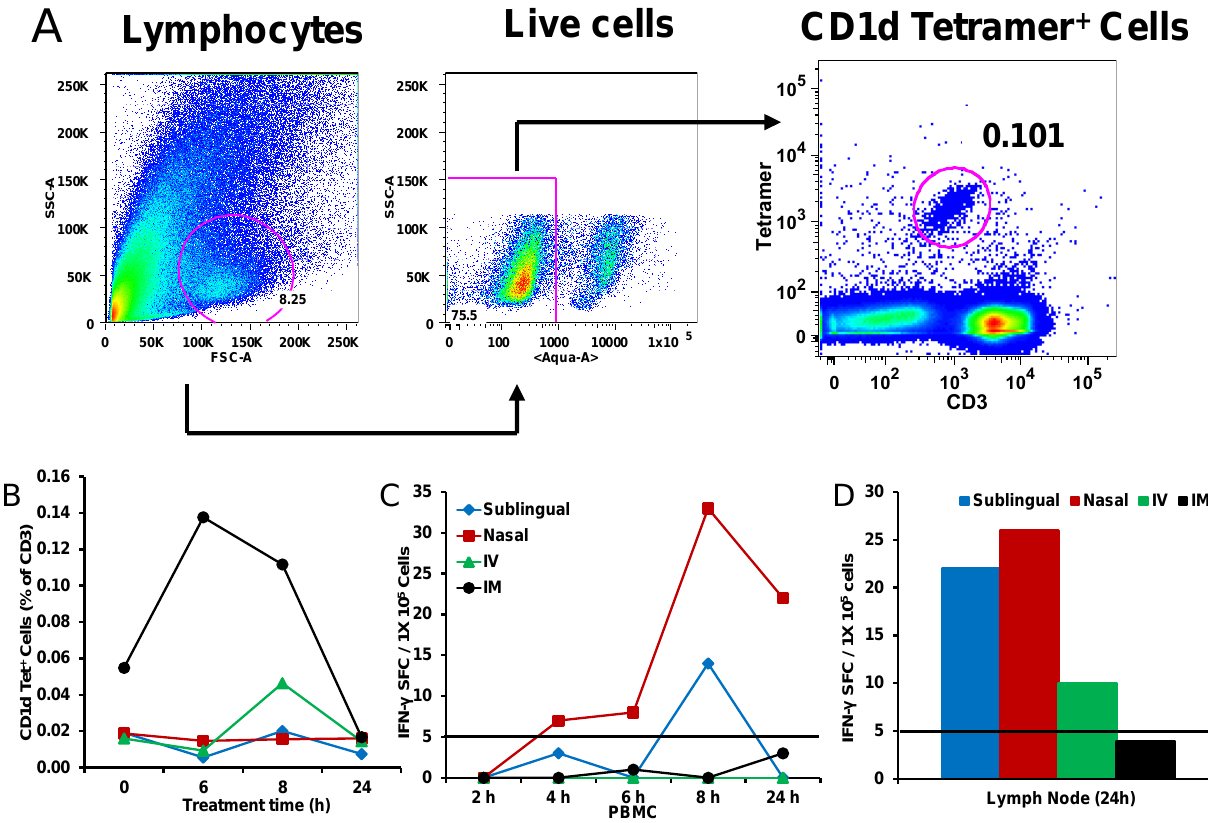
Figure 3. In vivo expansion of natural killer T (NKT) cells with α-GalCer delivered by different routes in rhesus macaques: Individual animals were administered α-GalCer as free drug (125 µg) by sublingual, intranasal (IN), intravenous (IV), and intramuscular (IM) routes followed by determining the percentages of NKT cells in the blood by staining with allophycocyanin (APC)-labeled CD1d tetramer pre-loaded with α-GalCer. The gating scheme ( A ) for the analyses of the NKT cells in the peripheral blood mononuclear cells (PBMC) from a representative animal included first selecting the lymphocytes based on forward scatter (FCS) versus side scatter (SSC), and then live lymphocytes were identified based on staining with Aqua Live/Dead reagent (Invitrogen, Carlsbad, CA, USA). The T cells were then positively identified by CD3 expression followed by the detection of the CD1d tetramer + populations within the CD3 + T cells. Percentages of CD1d tetramer + NKT cells in PBMC isolated from individual monkeys at 0, 6, 8 and 24 h after delivering α-GalCer by the different routes are shown in Figure 3B. Numbers of IFN-γ producing cells within the blood ( C ) and lymph nodes ( D ) after administering α-GalCer by the different routes in individual monkeys as an indication of activated NKT cells are enumerated by the standard cytokine ELISpot assay. Data are shown as IFN-γ spot forming cells (SFC) per 1 × 10 5 input cells and antigen specific responses were adjusted to background medium